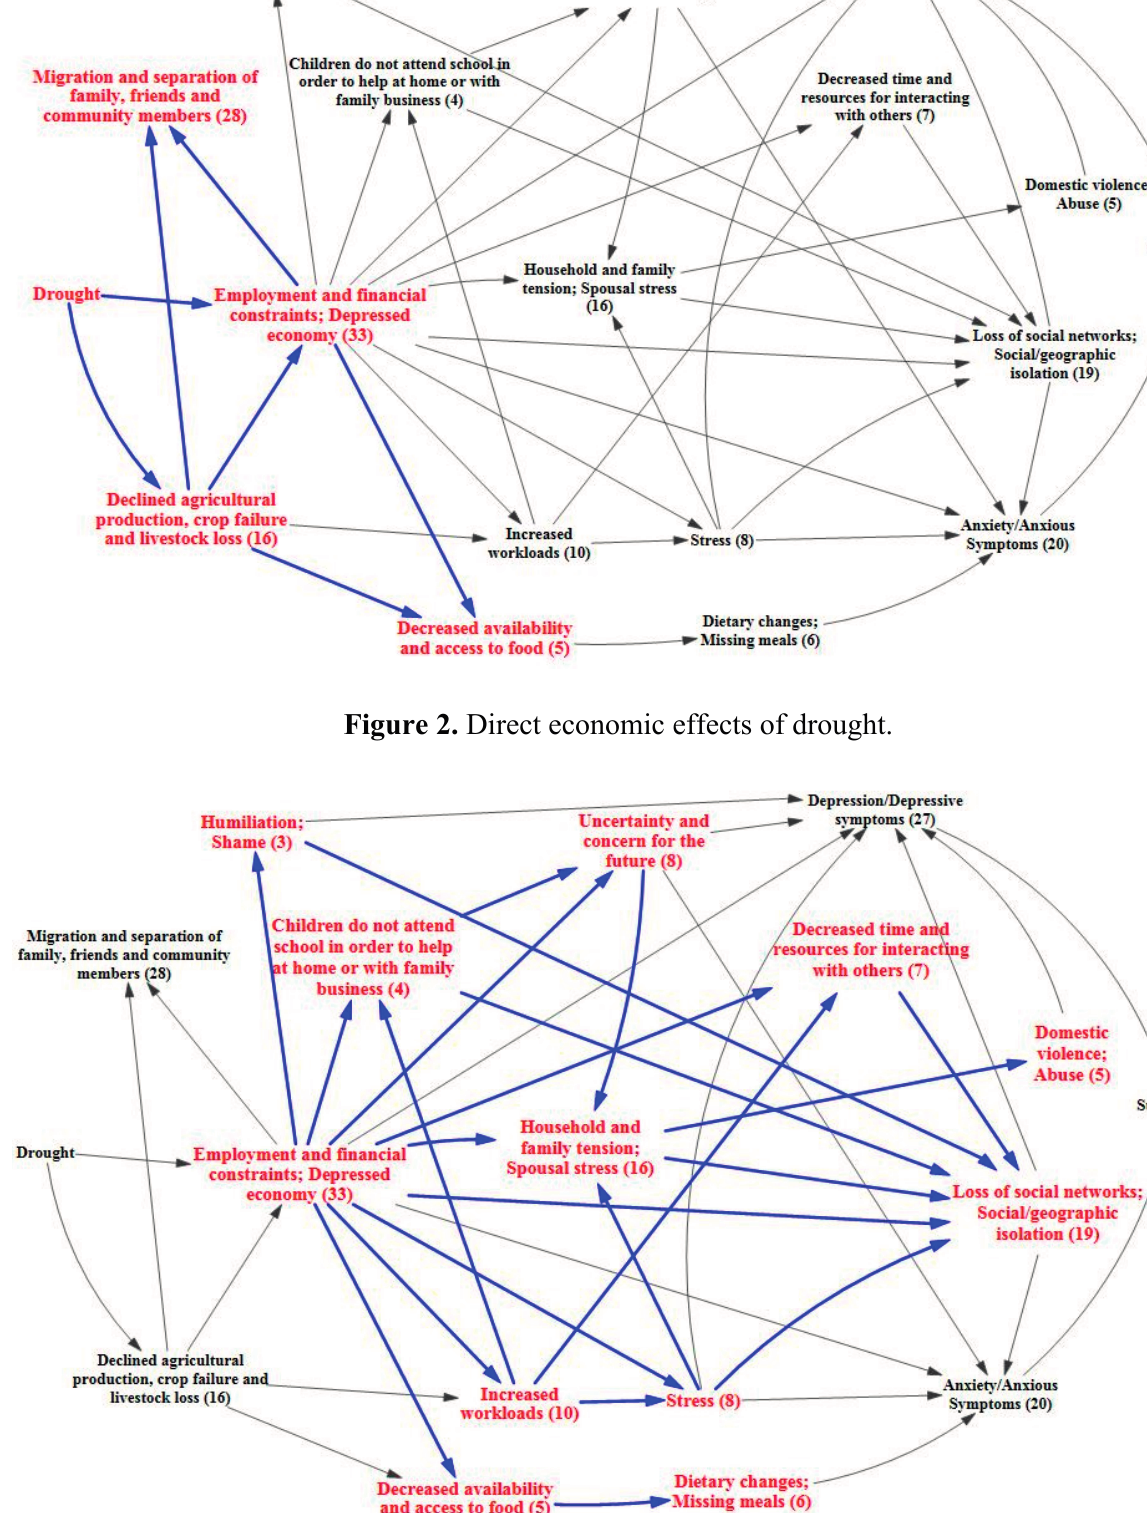
Figure 3. Intermediary factors of economic